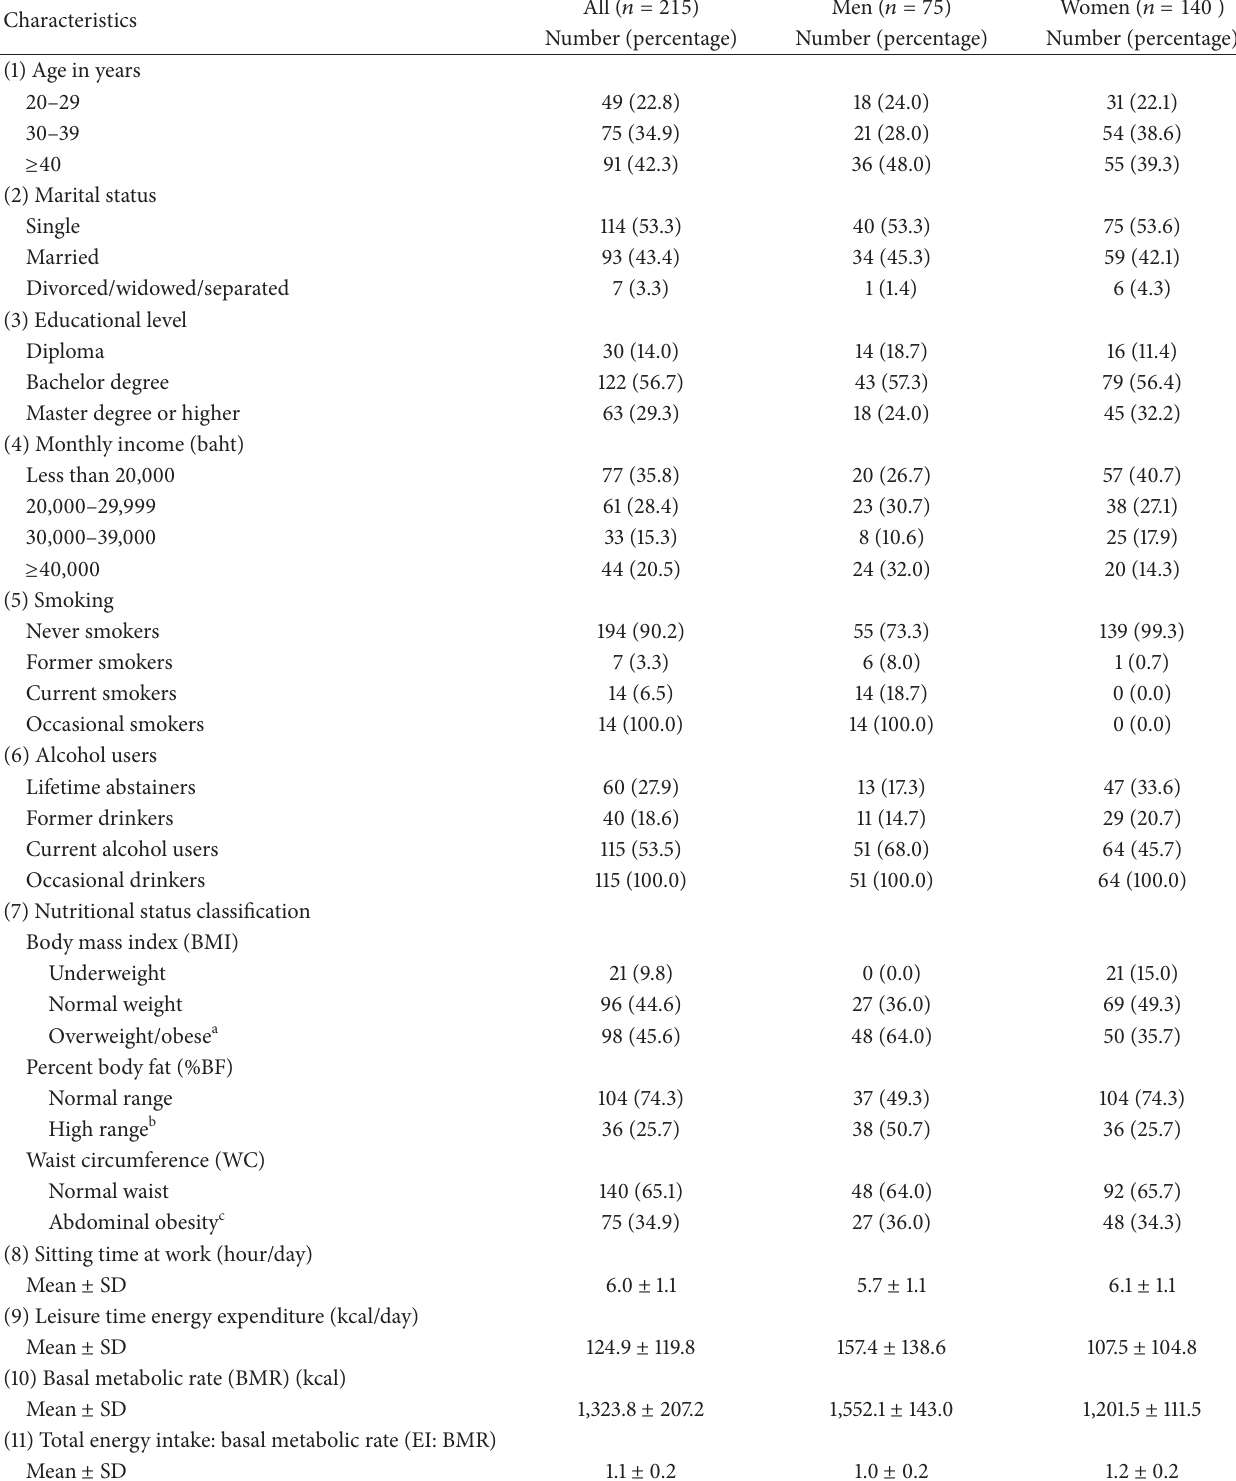
Table 2: Sociodemographic and anthropometric profile of